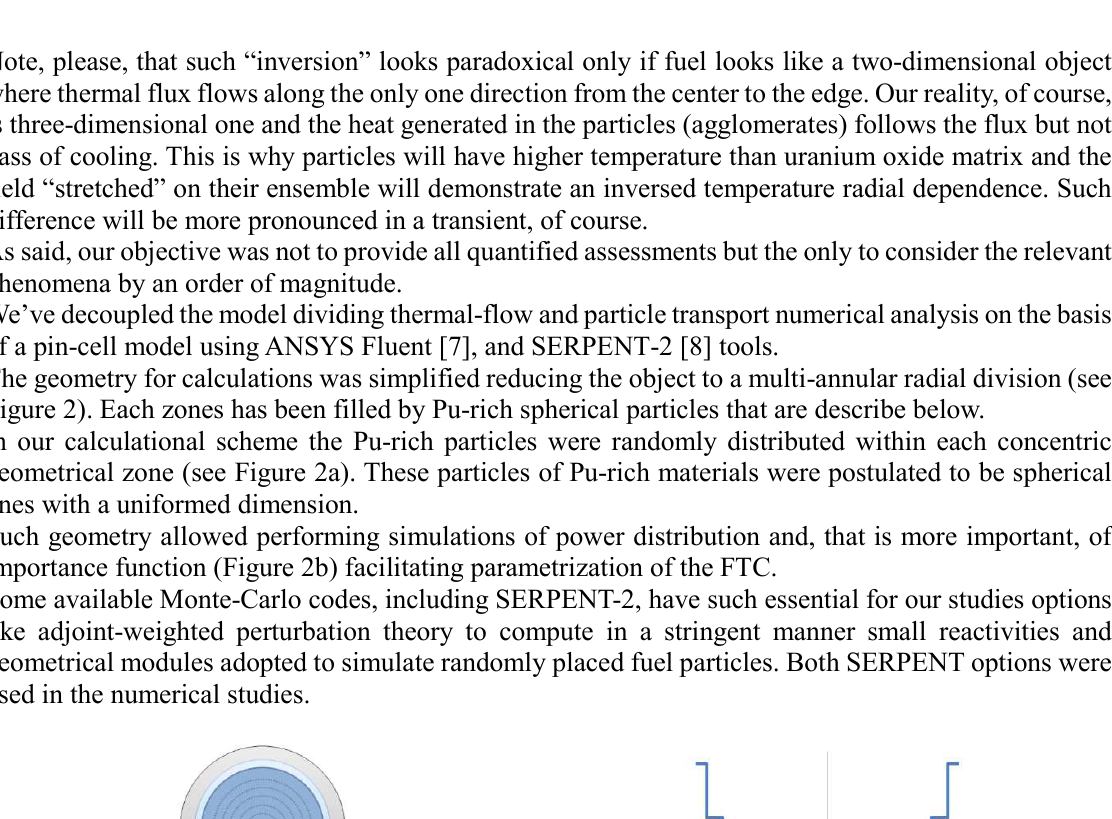
Figure 1: Temperatures in a homogeneous (a) media and in one with fissile agglomerates (b).